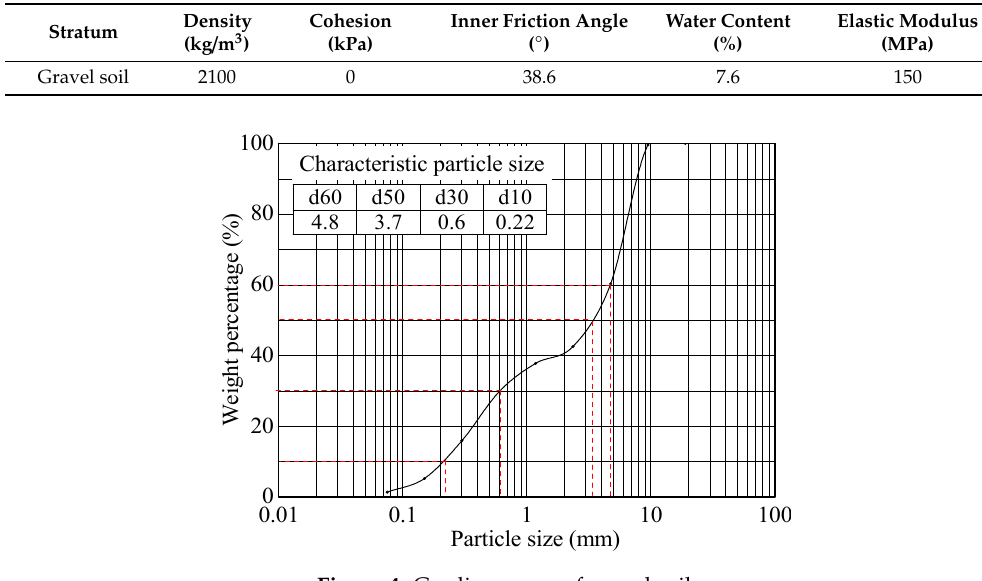
Figure 4. Grading curve of gravel soil.